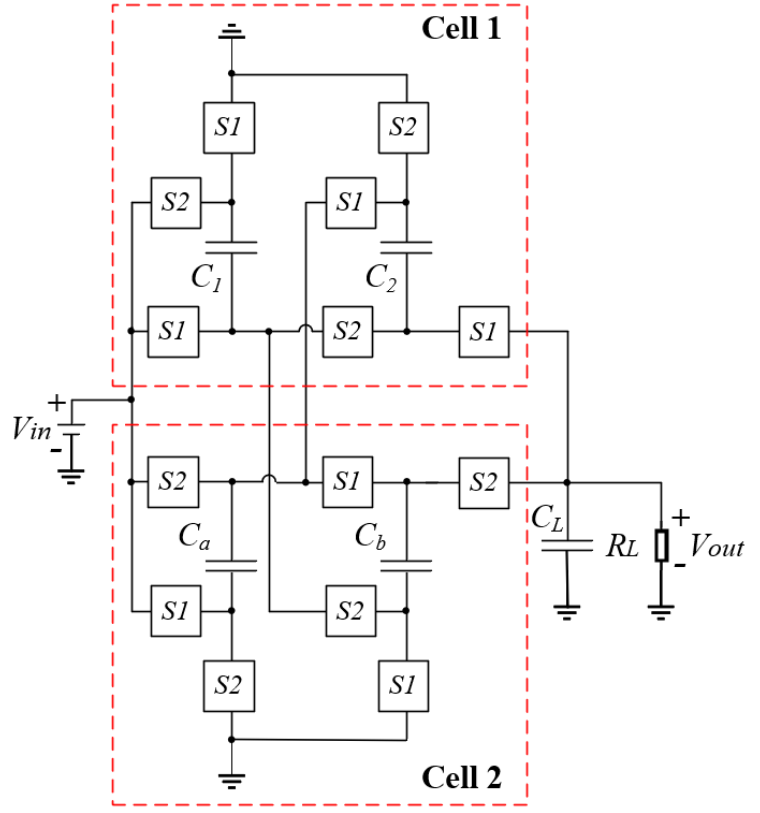
Figure 1. Four times step-up